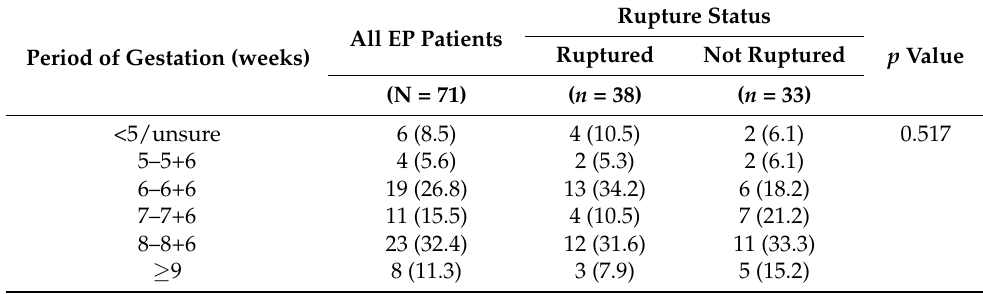
Table 5. Association between gestation period (weeks) and rupture status in ectopic pregnancies. Rupture All EP Patients Period of Gestation (weeks)